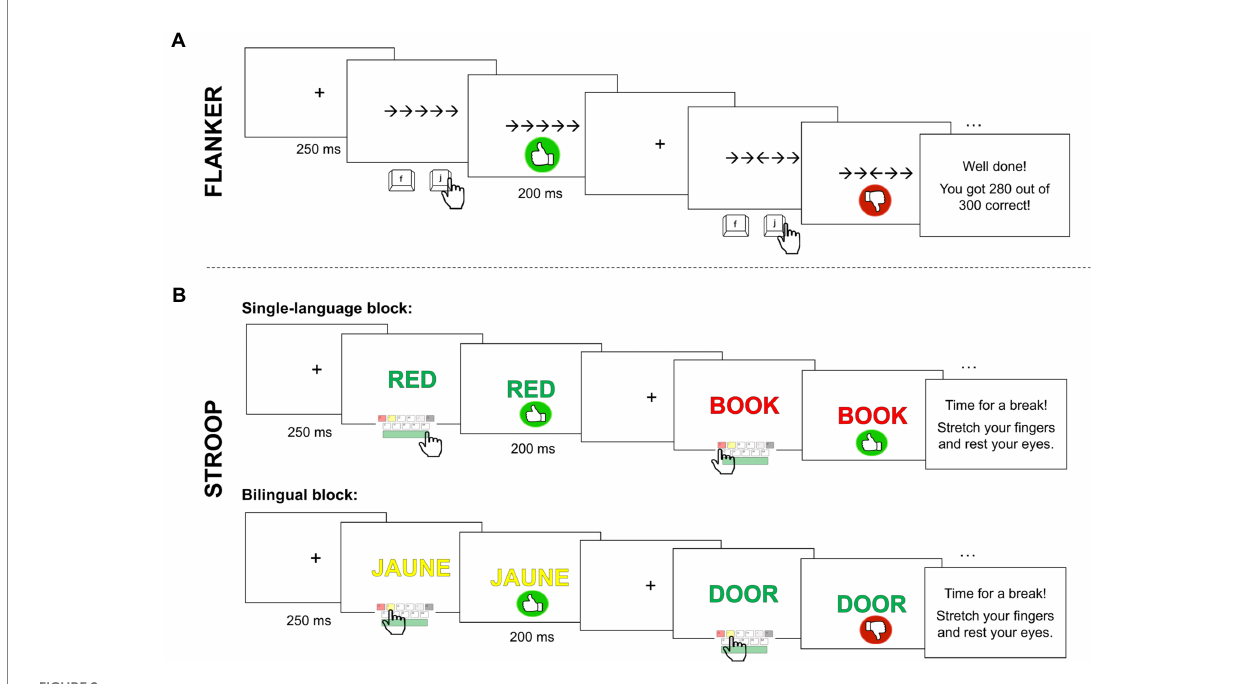
FIGURE 2 Procedure for the Flanker (A) and Stroop (B) tasks. Both the single-language and bilingual blocks are depicted for the Stroop